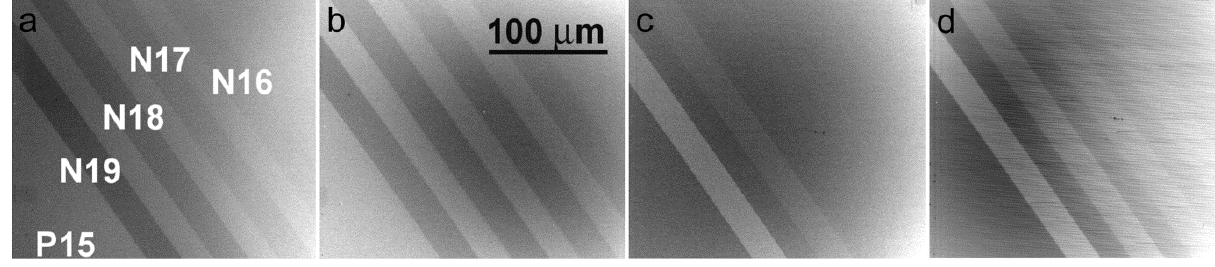
Figure 22. N-type doped stripes on the p-type Si substrate (Nx or Px means the dopant density of 10 x cm − 3 ), sample immersed in 1 kV/mm field, landing energy of electrons as follows. ( a ) 2.5 keV; ( b ) 1 keV; ( c ) 100 eV; ( d ) 2.3